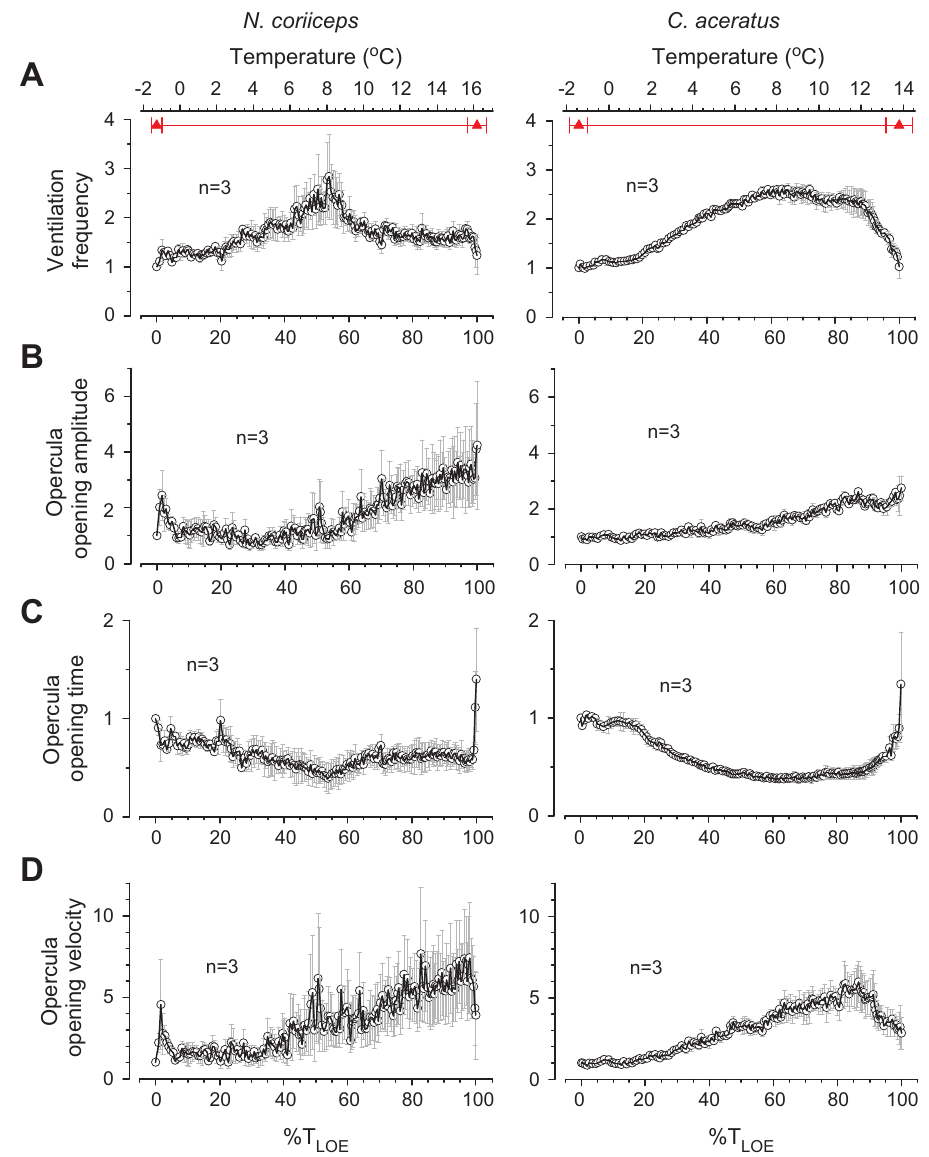
Fig 5. Thermally induced ventilatory responses in Hb+ N . coriiceps and Hb- C . aceratus . (A) Ventilation frequencies ( f ). (B) Opercula opening amplitudes (OA). (C) Opercula opening times (OT). (D) Opercula opening v velocity (OV). Data points and error bars in all plots represent means and SEM of each metric normalized to the initial value for each animal, and averaged for three specimens of each species. For conventions of quantification and presentation of grouped data as a function of temperature, see Materials and Methods.